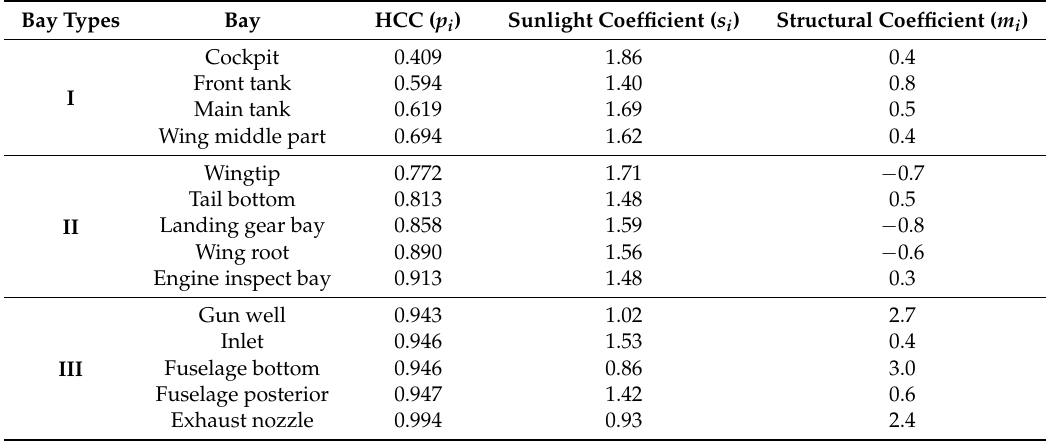
Table 2. Bay classification based on humidity characteristic and key coefficient values of each